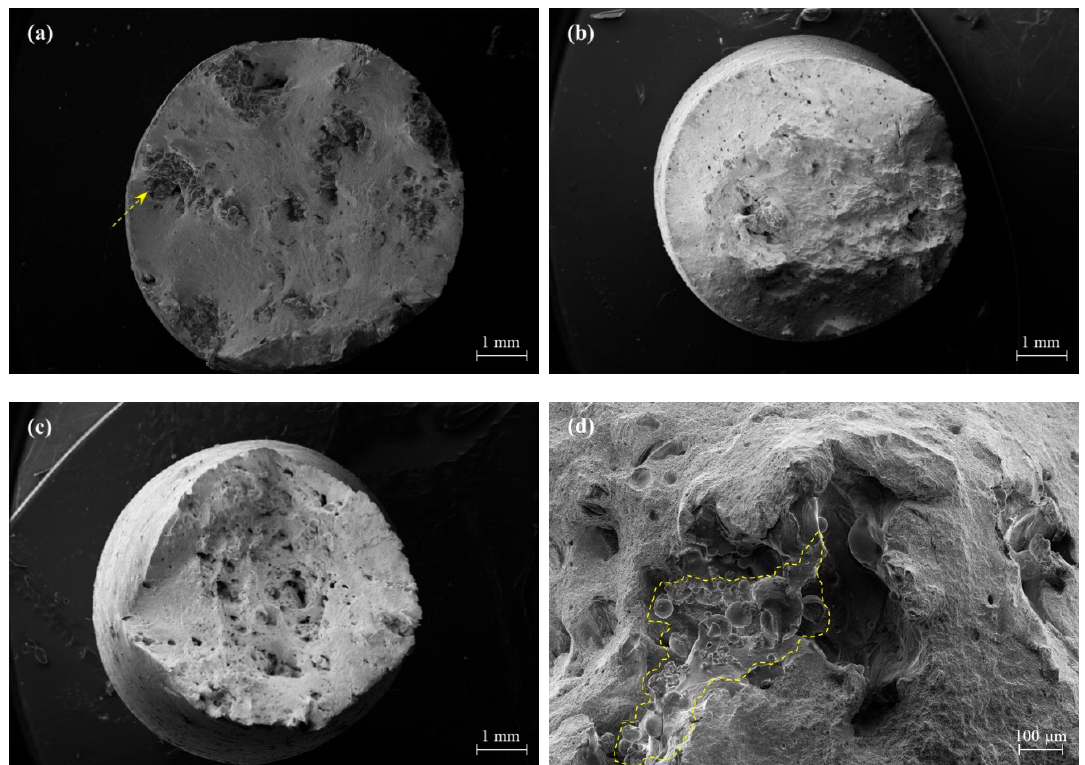
Figure 13. Views of broken tensile specimens of ( a ) as-built W-2 (arrowed are the rough regions associated with defects), ( b ) quench and tempered W-3, ( c ) as-built W-4, and ( d ) quenched W-2 steels (the highlighted area is a lack-of-fusion region with evidence of non-molten powder particles).